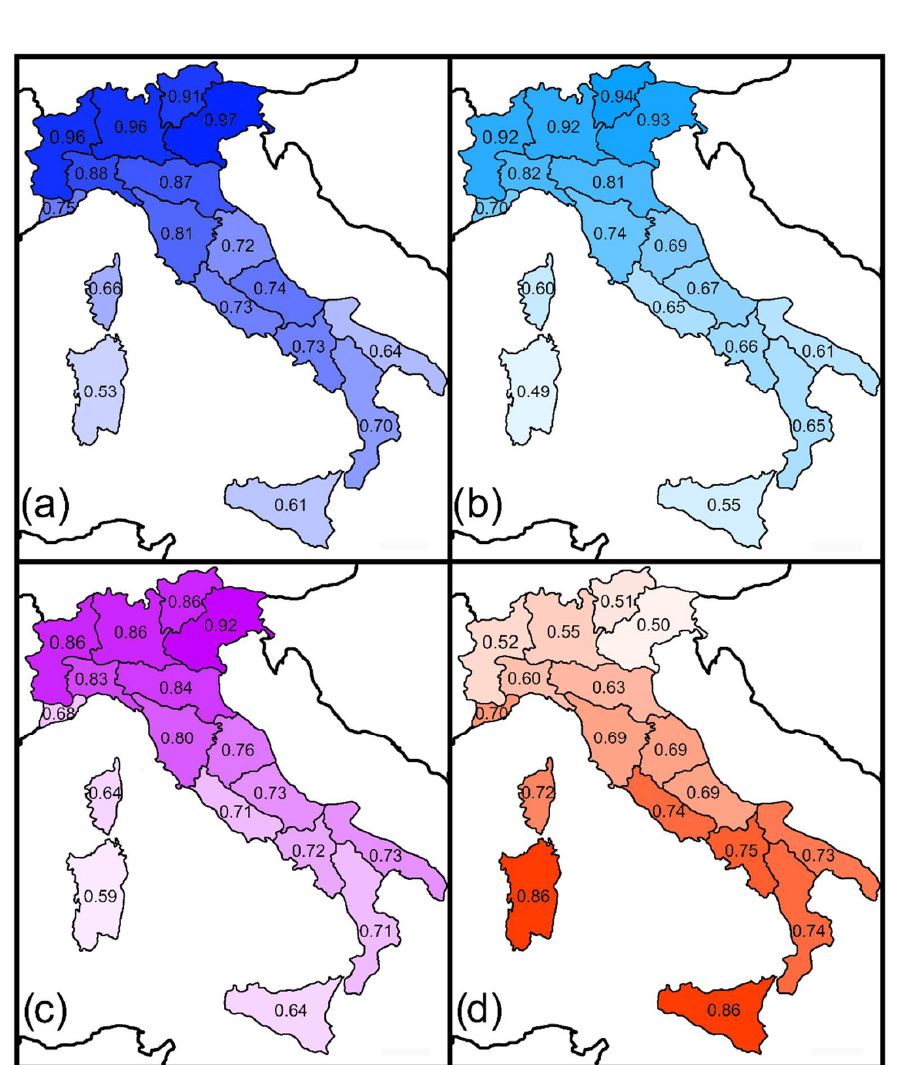
Figure 3. Spatial variations in the Sørensen index between Italian regions and adjacent major areas for odonates (total number of species): ( a ) Western Europe; ( b ) Central Europe; ( c ) Eastern Europe; ( d ) Northern Africa. Results for Zygoptera and Anisoptera are shown in Figures S1 and S3, respec-